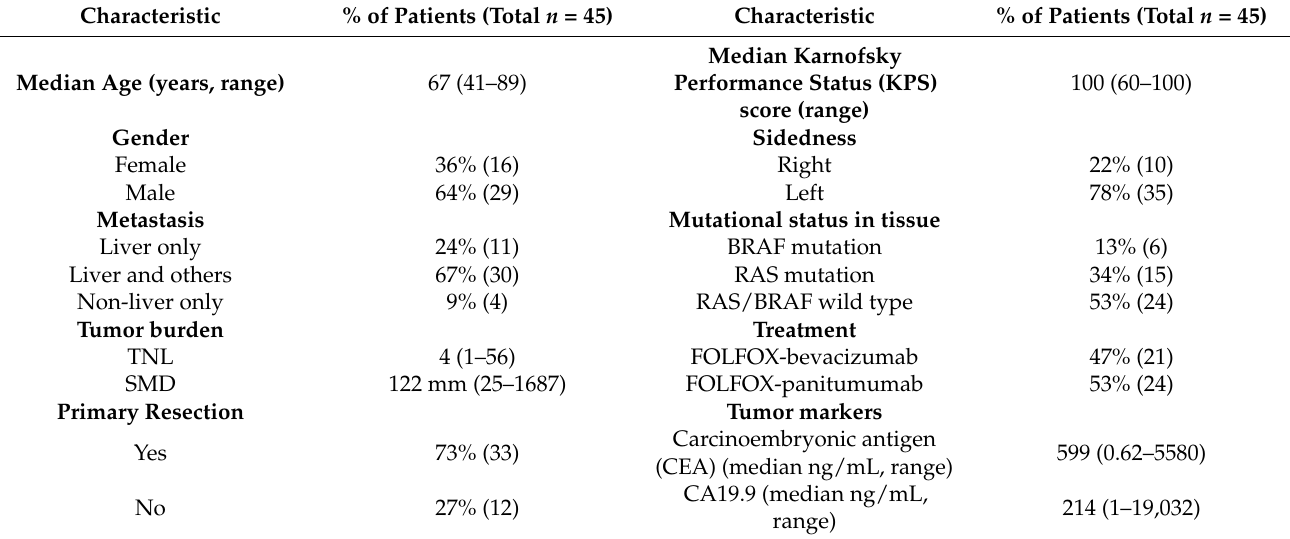
Table 1. Patients characteristics. KPS: Karnosky Performance Status. TNL: total number of tumor lesions. SMD: sum of maximum diameter of all measurable lesions in